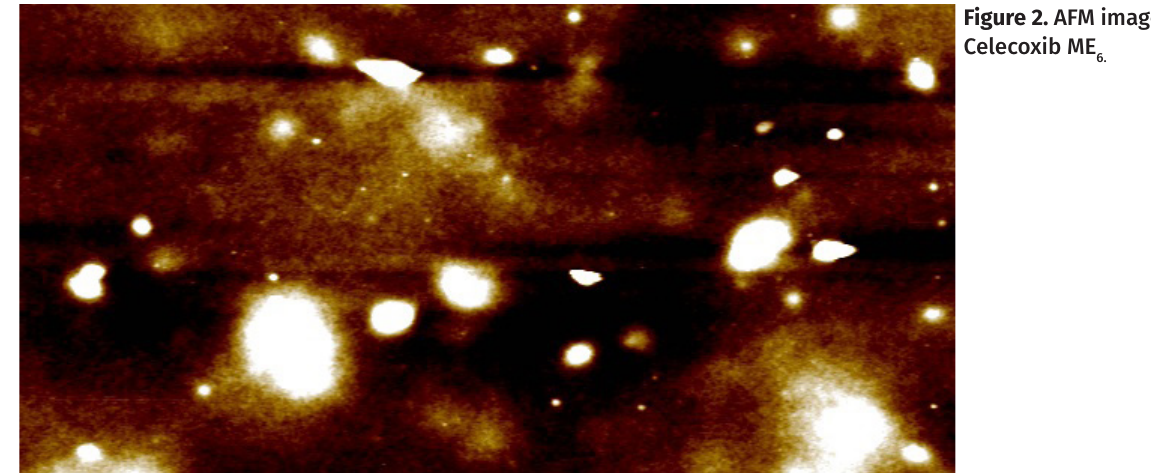
Figure 2. AFM image of Celecoxib ME